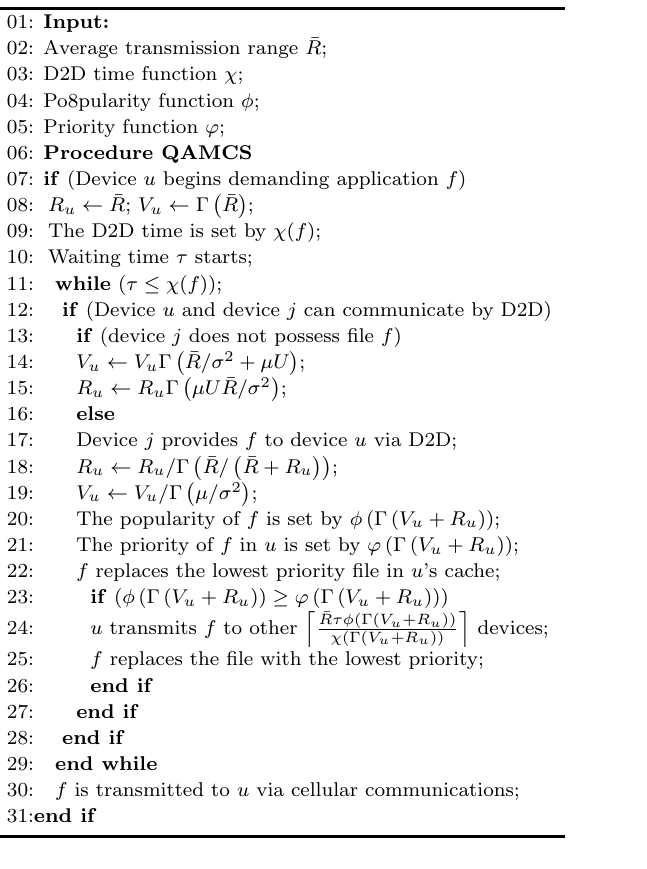
Algorithm I: QoE-Aware Multimedia Commun.